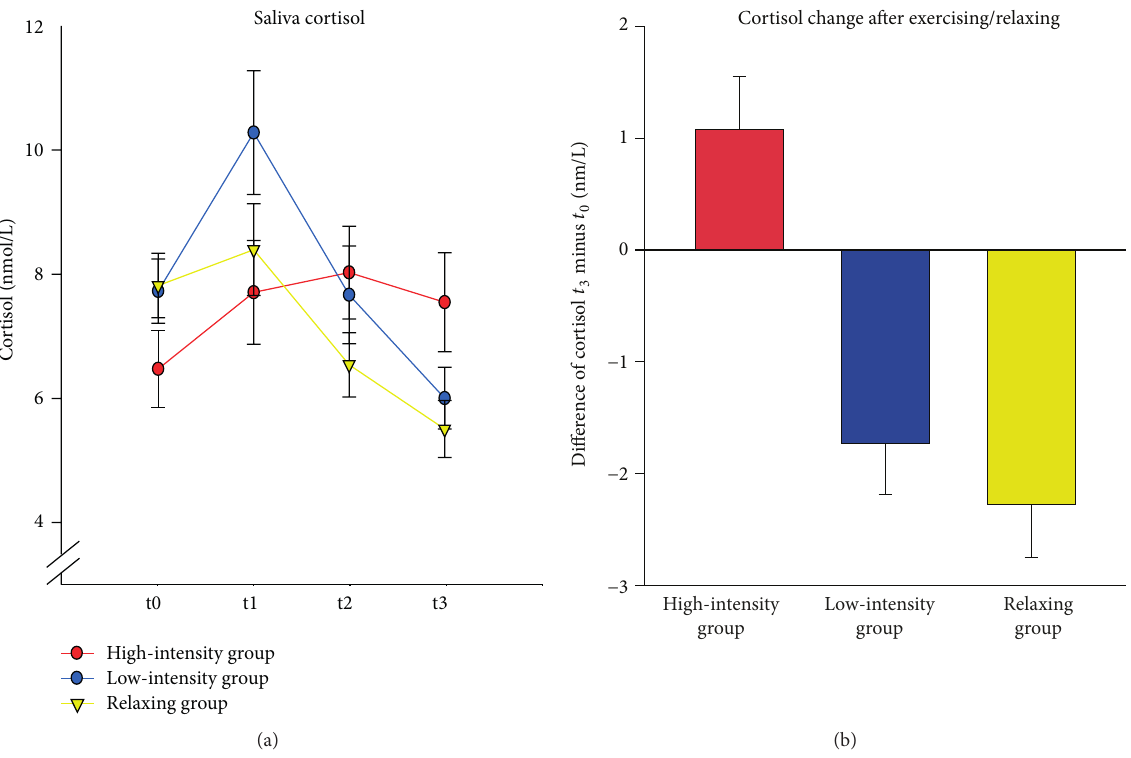
Figure 4: (a) Mean saliva cortisol at baseline ( 𝑡 0 ), after learning ( 𝑡 1 ), after exercising/relaxing ( 𝑡 2 ), and 20 minutes after exercising ( 𝑡 3 ), separately for the high-intensity exercise group, the low-intensity exercise group, and the relaxing group. (b) Mean changes in cortisol from baseline to the assessment 20 minutes after exercising/relaxing. Positive values indicate an increase in cortisol. Error bars depict ± 1 standard error of the